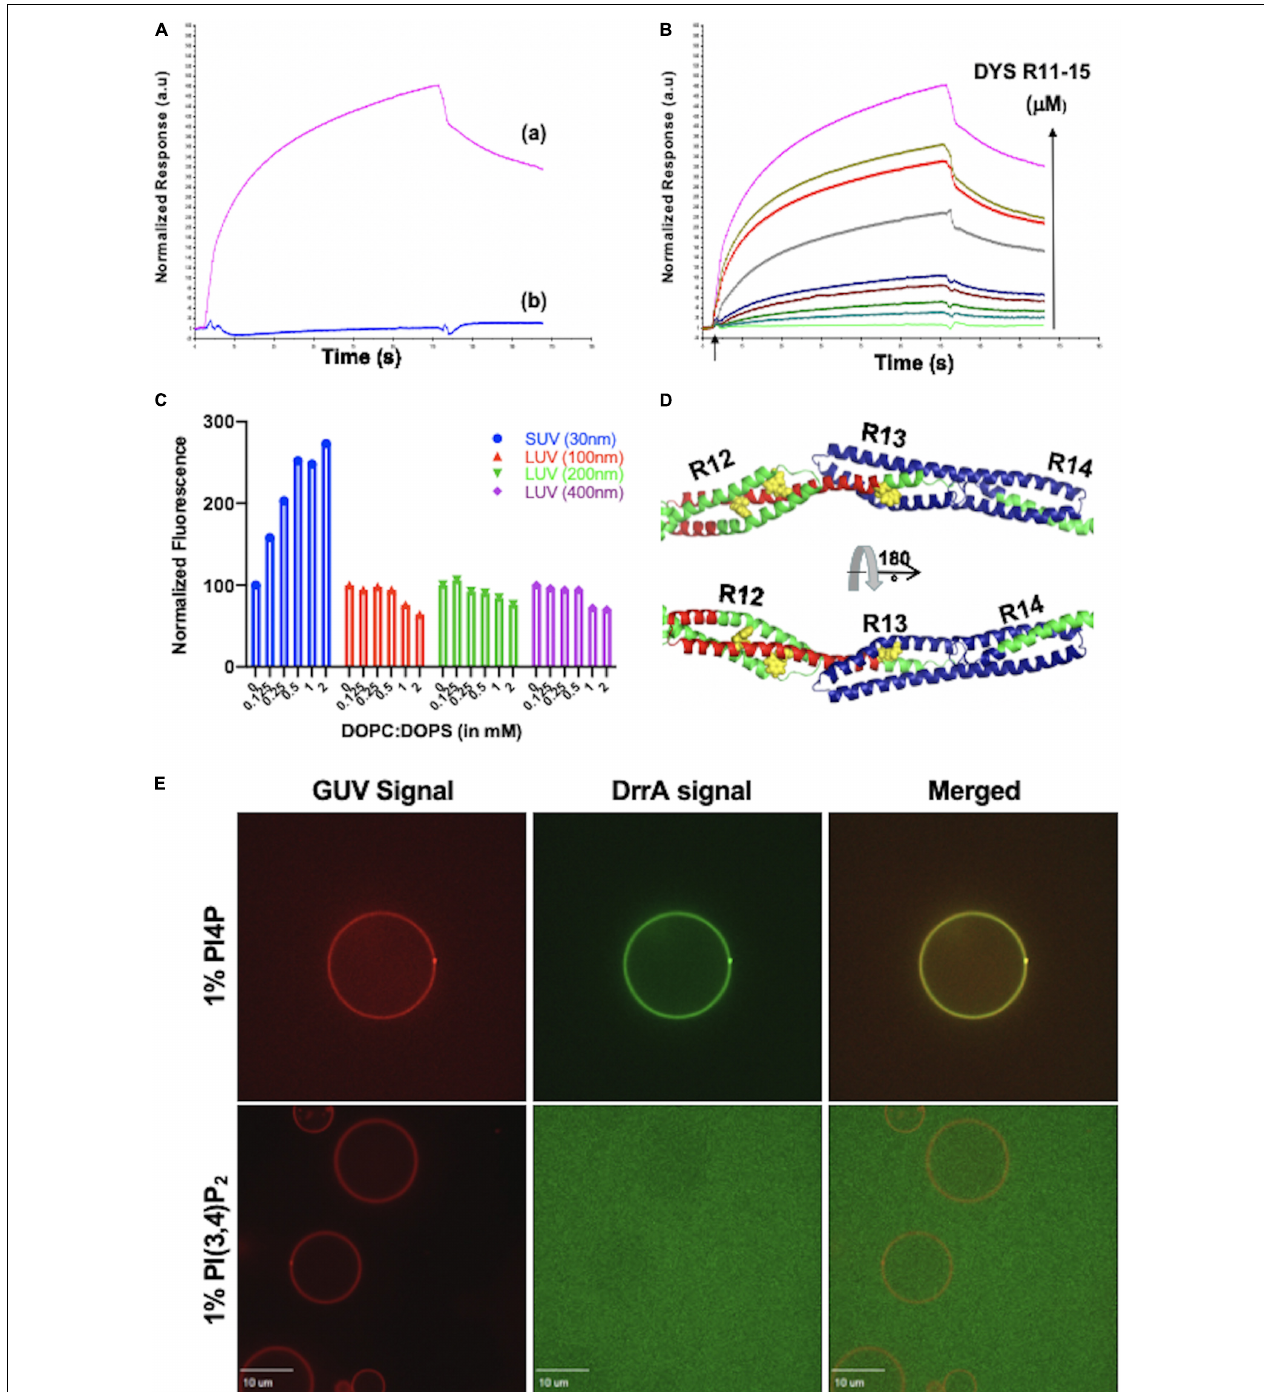
FIGURE 3 | (A) Surface Plasmon Resonance traces showing the binding of DYS R11-15 to DOPC:DOPS (a) and to DOPC:DOPE (b) SUVs. (B) SPR traces of DYS R11-15 binding to DOPC:DOPS SUVs in a dose dependent manner. (A,B) Figures are adapted from Sarkis (2012). (C) Fluorescence intensity of tryptophan residues in DYS R11–15 (0.5 µ M) after 2 h of incubation with different concentrations of DOPC/DOPS. SUV diameter was 30 nm and LUV of three different sizes: 100, 200, and 400 nm. Modified from Sarkis et al. (2011). (D) Structure of DYS R12-14 (PyMol) obtained by sequence homology illustrating the protected zone from trypsin in red, due to the direct binding to anionic SUV, the unprotected zone in shown in blue, which is more sensitive to trypsin digestion when vesicles are present. Residues in yellow correspond to Tryptophan. Adapted from Sarkis et al. (2011). (E) Confocal microscopy images of different composition of GUV incubated with DrrA. GUVs contains 20% DOPC, 15% DOPS, 35% DOPE, 30% cholesterol and 1% PI4P or PI(3,4)P2. Reproduced by J. S. from Schoebel et al. (2010); Del Campo et al. (2014), and Sidm and Wang (2016).